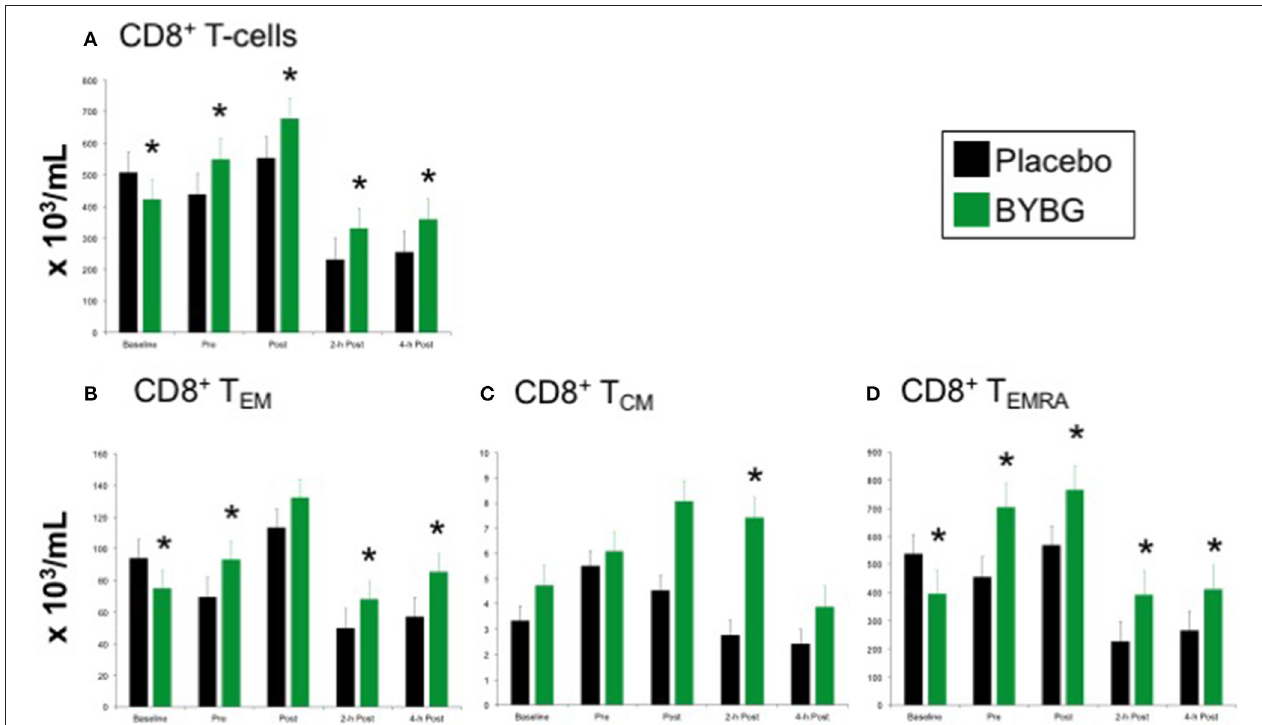
FIGURE 6 | Effect of BYBG on CD8 + T cells. CD8 + T cell concentrations were determined using peripheral blood mononuclear cells (PBMC) isolated from human whole blood samples. PBMCs were analyzed using flow cytometry to determine total ( A , CD3 + /CD8 + ), T EM ( B , CCR7-/CD45RA-), and T CM ( C , CCR7 + /CD45RA-), and T EMRA ( D , CCR7-/CD45RA + ) concentrations. Placebo (black bars) and BYBG (green bars) are represented separately and were statistically compared. Values represent the mean ± SEM. *indicates BYBG significantly different than placebo ( p <